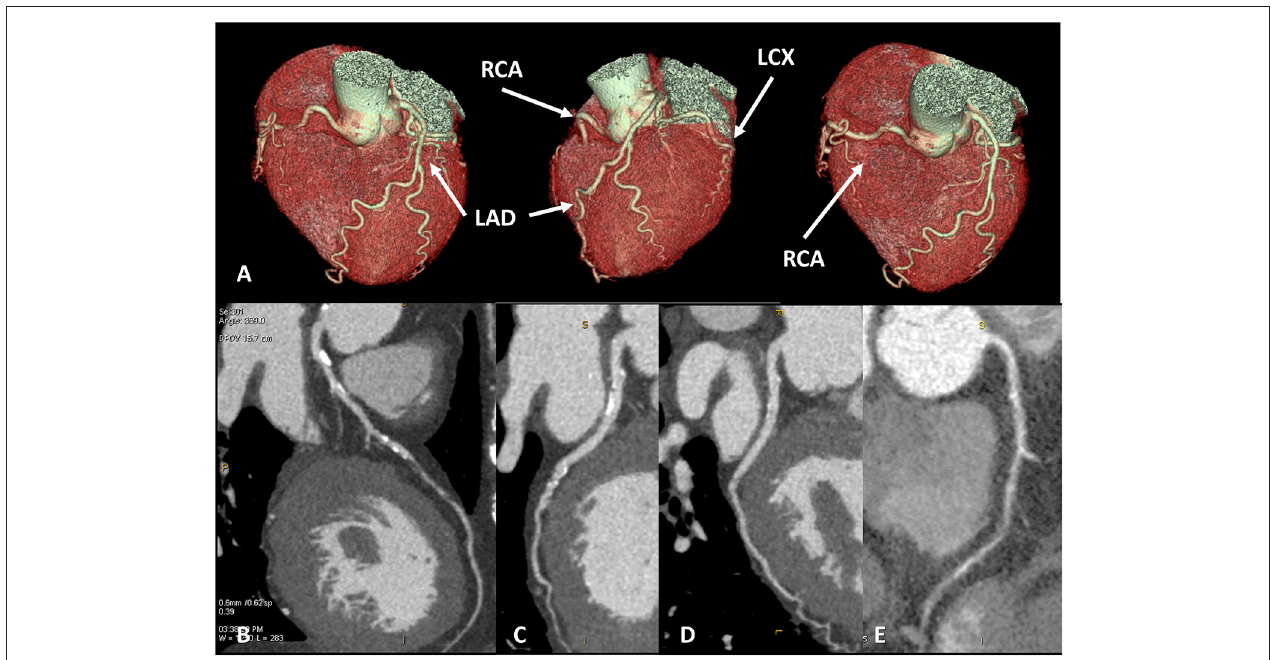
FIGURE 1 | Coronary artery anatomy evaluation. A case example of 65 years old female patients with newly diagnosed severe reduction of left ventricular ejection fraction ( < 30%), symptomatic for dyspnea. Cardiac CT was performed with optimal image quality (A) . A severe multivessel coronary artery disease was found with a subocclusive lesion on mid-left anterior descendent artery (B) , significative lesion on left-circumflex artery (C) , no significative lesion on the marginal branch and subocclusive disease on right coronary artery (D,E) .